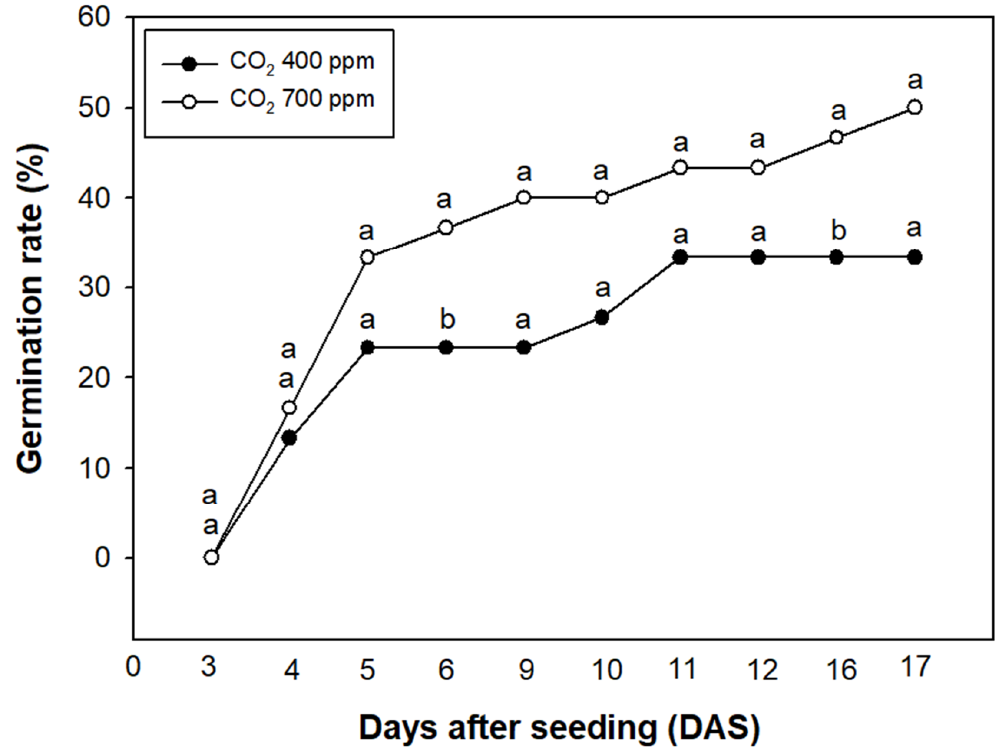
Figure 4. Germination rate (%) of A. patulus grown under 400 or 700 ppm CO 2 in growth chambers. Means within a figure followed by the same letters are not significantly different at the 5% level according to Duncan’s Multiple Range Test.